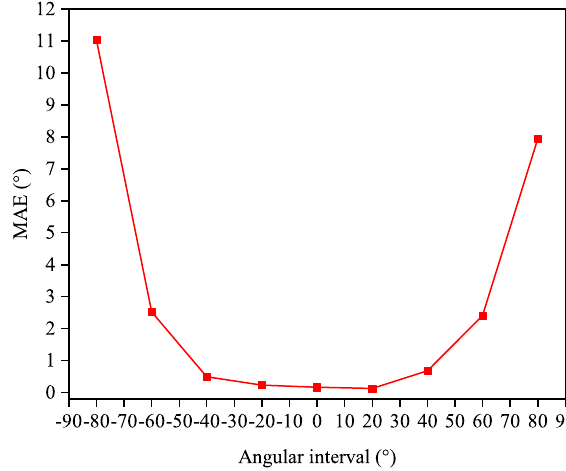
Figure 3. Mean absolute error (MAE) response curve of the multi-label classifiers in different sectors at the signal-to-noise (SNR) of 20